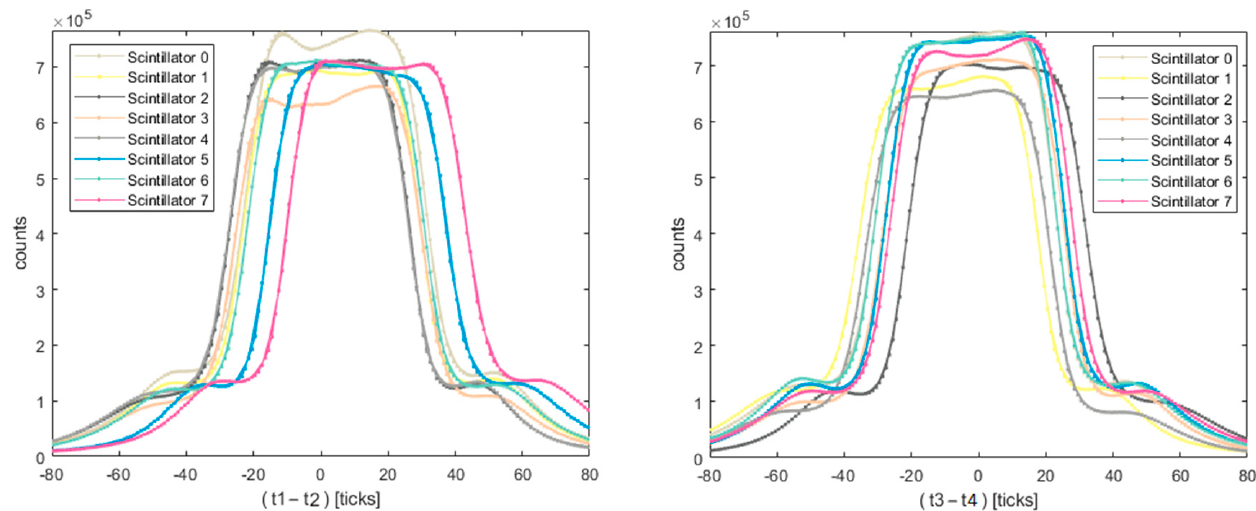
Figure A2. Distributions of time differences read out from the ends of LIDAL plastic scintillators (left and right for LDU0 and LDU1, respectively), derived from about two years of flight data. Distributions are not zero ‑ centered, and temporal corrective terms must be introduced.